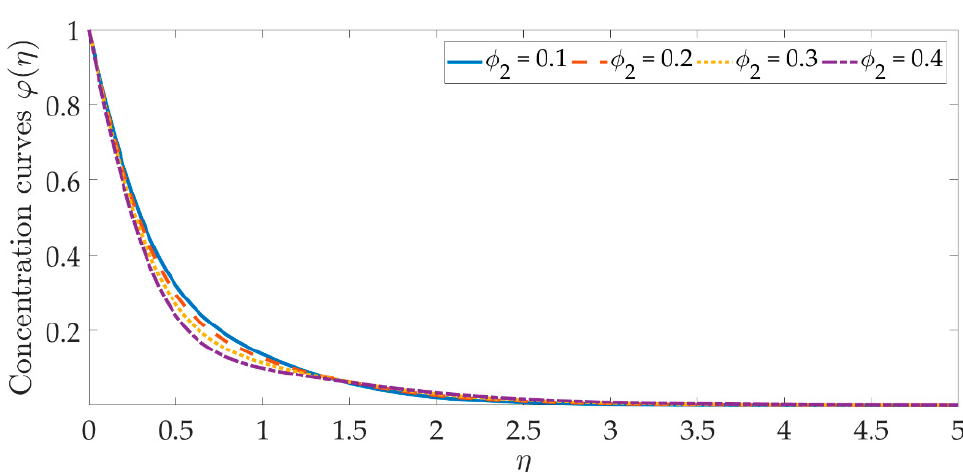
Figure 14. Concentration curves against the multiple values of 1 .